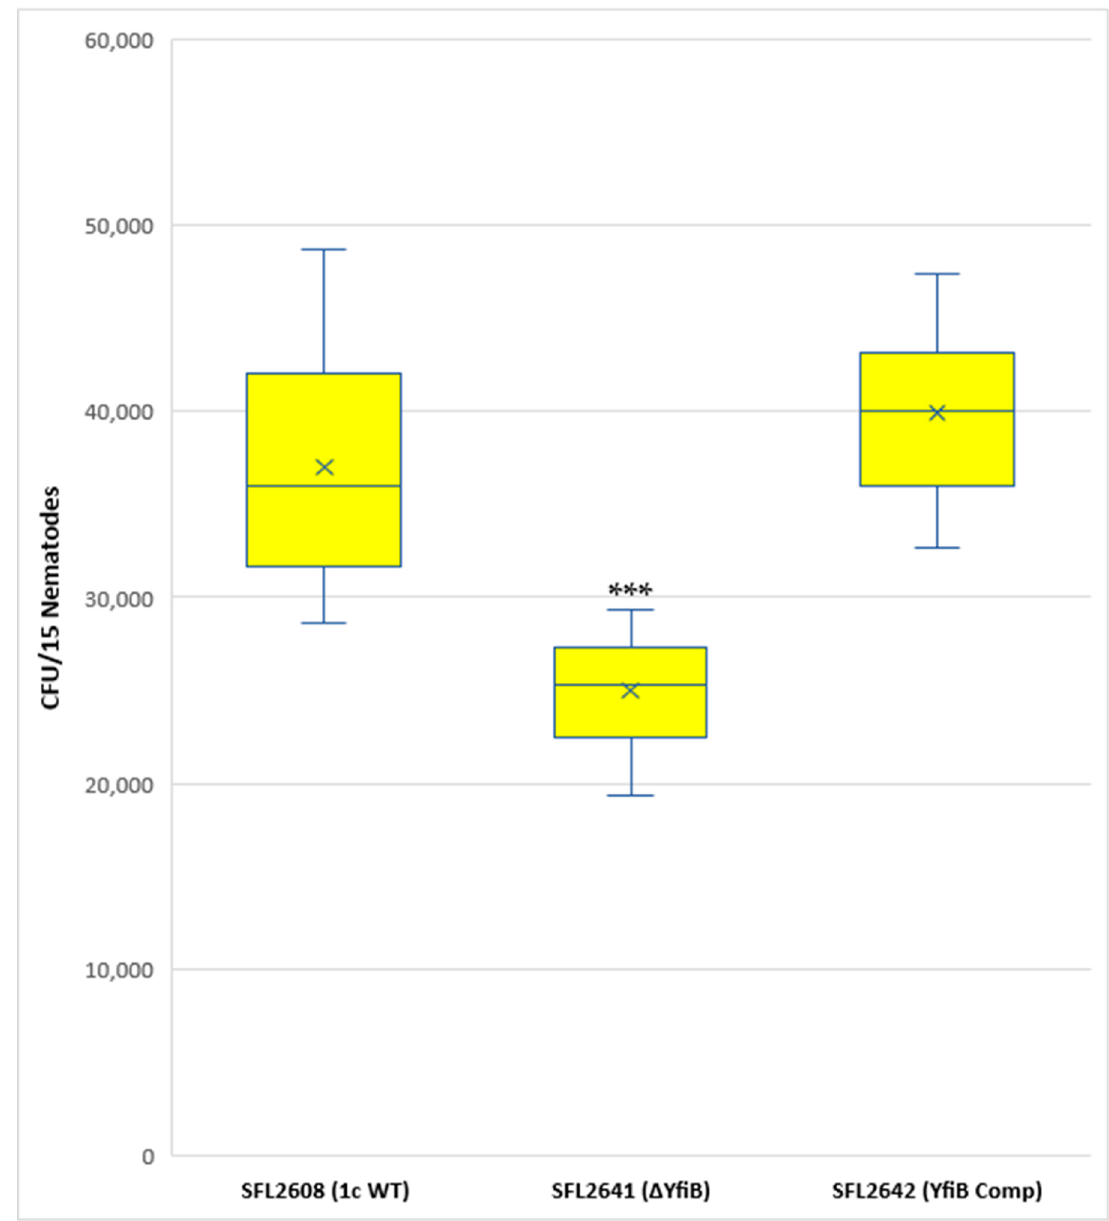
Figure 7. Quantification of bacterial colonization in C. elegans . The synchronized L4-stage N2 nematodes were fed with 1c WT (SFL2608), yfiB KO mutant SFL2641 ( ∆ yfiB), and yfiB -complemented strain SFL2642 (YfiBComp) for 24 h at 22 °C. From each plate, 15 worms were picked, lysed utilizing glass beads, after which suitable dilutions of individual lysate were plated on LB agar plates to attain bacterial colonization numbers. To analyse the observed variance in colonization numbers between the strains, a Student’s t-test was performed. The 1c WT (SFL2608) and yfiB -complemented strain SFL2642 (YfiBComp) showed higher accumulation in C. elegans , when compared to yfiB KO mutant SFL2641 ( Δ yfiB) strain. Statistically significant ( p value < 0.001) variance is indicated by the three asterisks and the analysis was based on three independent repeats.